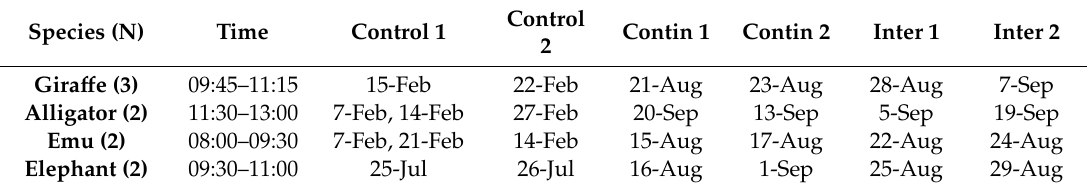
Table 1. Schedule of noise exposure treatments: Control (ambient sound), Continuous construction noise (Contin), and Intermittent construction noise (Inter). All recordings were collected in 2017 except for the Gira ff e Control treatments which were in